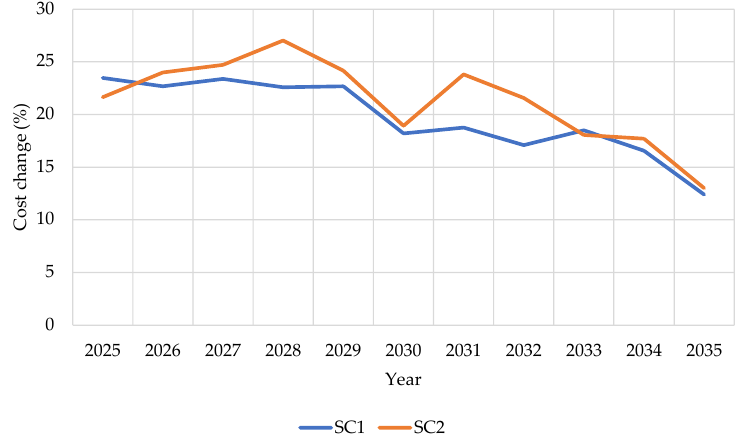
Figure 7. Cost change (%) in the case of the loss of biomass supply.